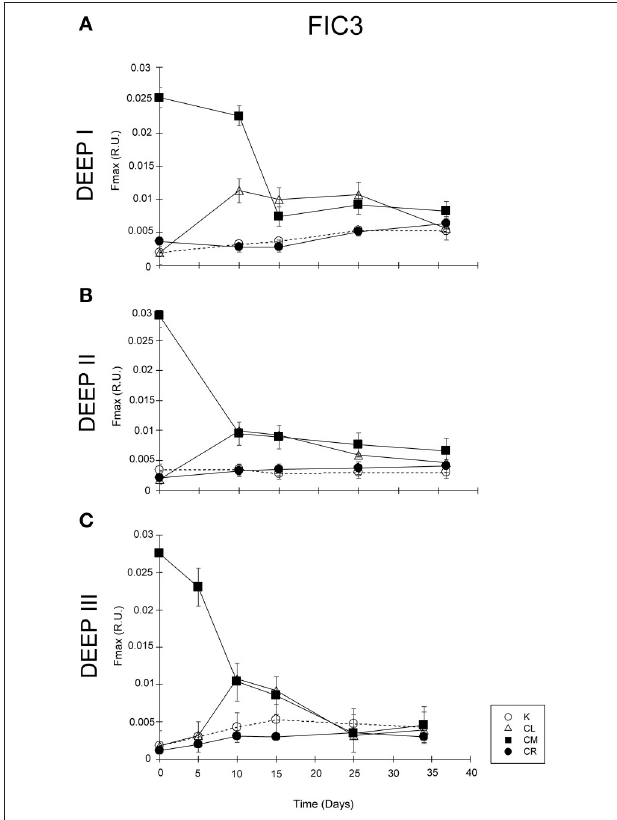
FIGURE 6 | Temporal evolution of FIC3 component in (A) DEEP I, (B) DEEP II, and (C) DEEP III for the four experimental conditions. Values expressed in R.U.